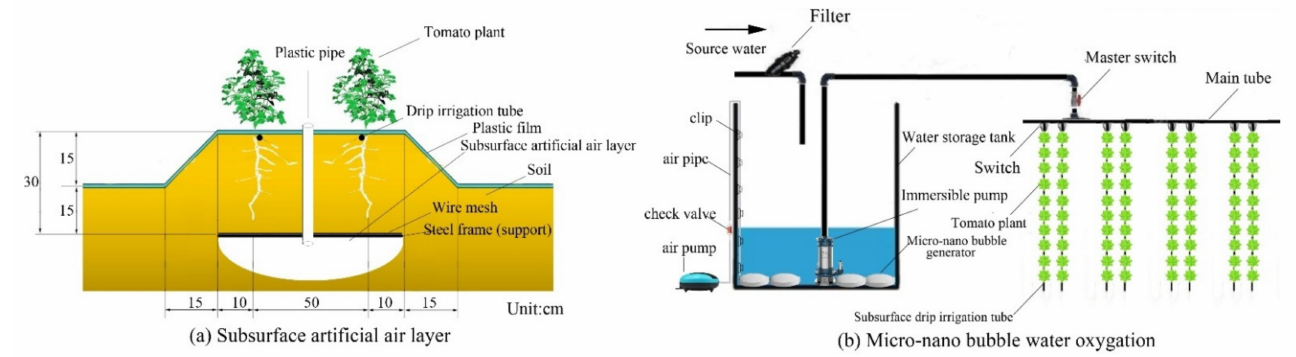
Figure 1. Sketch map of ( a ) subsurface artificial air layer aeration and ( b ) micro–nano-bubble water